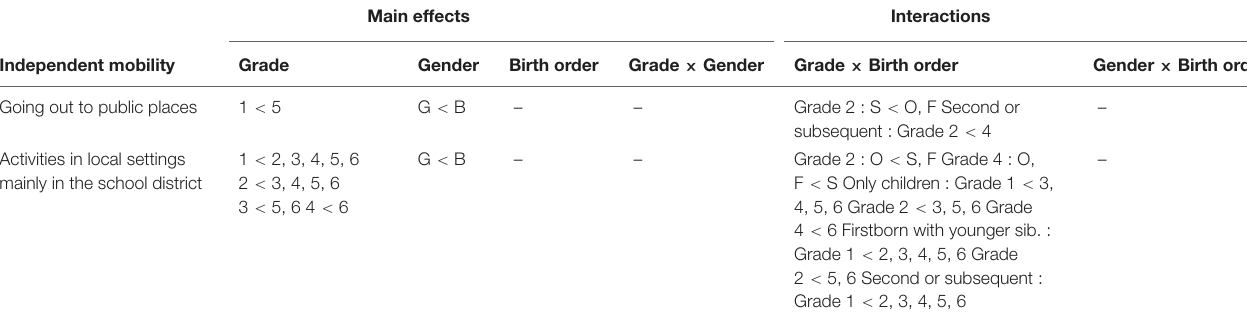
TABLE 4 | Summary of three-way analysis with grade, gender, and birth order.